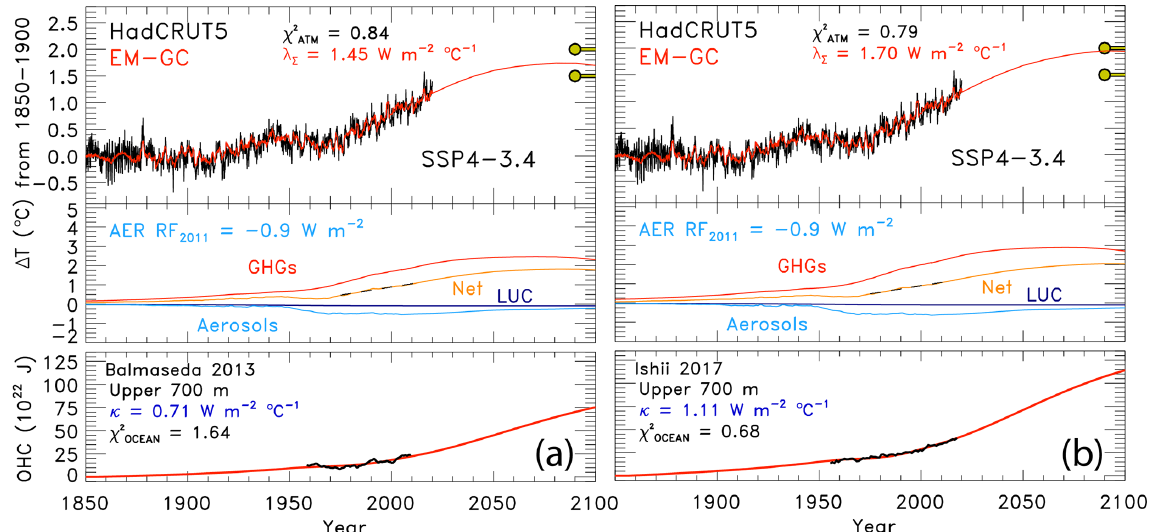
Figure 4. Measured (HadCRUT5) and EM-GC simulated GMST change ( (cid:49)T ) from 1850–2019, as well as projected (cid:49)T to the year 2100 for SSP4-3.4. The top box in each panel shows observed (black) and simulated (red) (cid:49)T , the λ (cid:54) and χ 2 values, and the Paris Agreement ATM target and upper limit. The second row of boxes displays the contribution of GHGs, aerosols, and land-use change to (cid:49)T . The bottom boxes compare the observed (black) and modeled (red) OHC for two different OHC records and display the value of κ needed to provide best fits to the OHC record, as well as best-fit values of χ 2 . Both use an aerosol RF in 2011 of − 0 . 9Wm − 2 . (a) OHC record from Balmaseda OCEAN et al. (2013). (b) OHC record from Ishii et al.